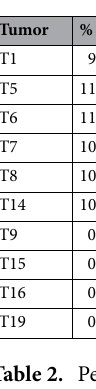
Table 2. Percent signature 26 and microsatellite instability in AA